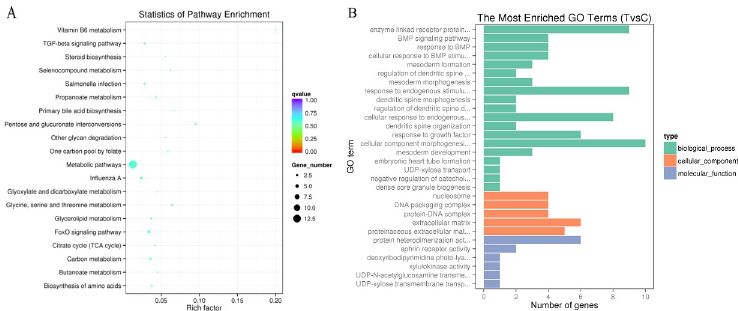
Fig 4. Regulatory networks of the differentially expressed miRNAs and their putative genes involved in intestinal damage.